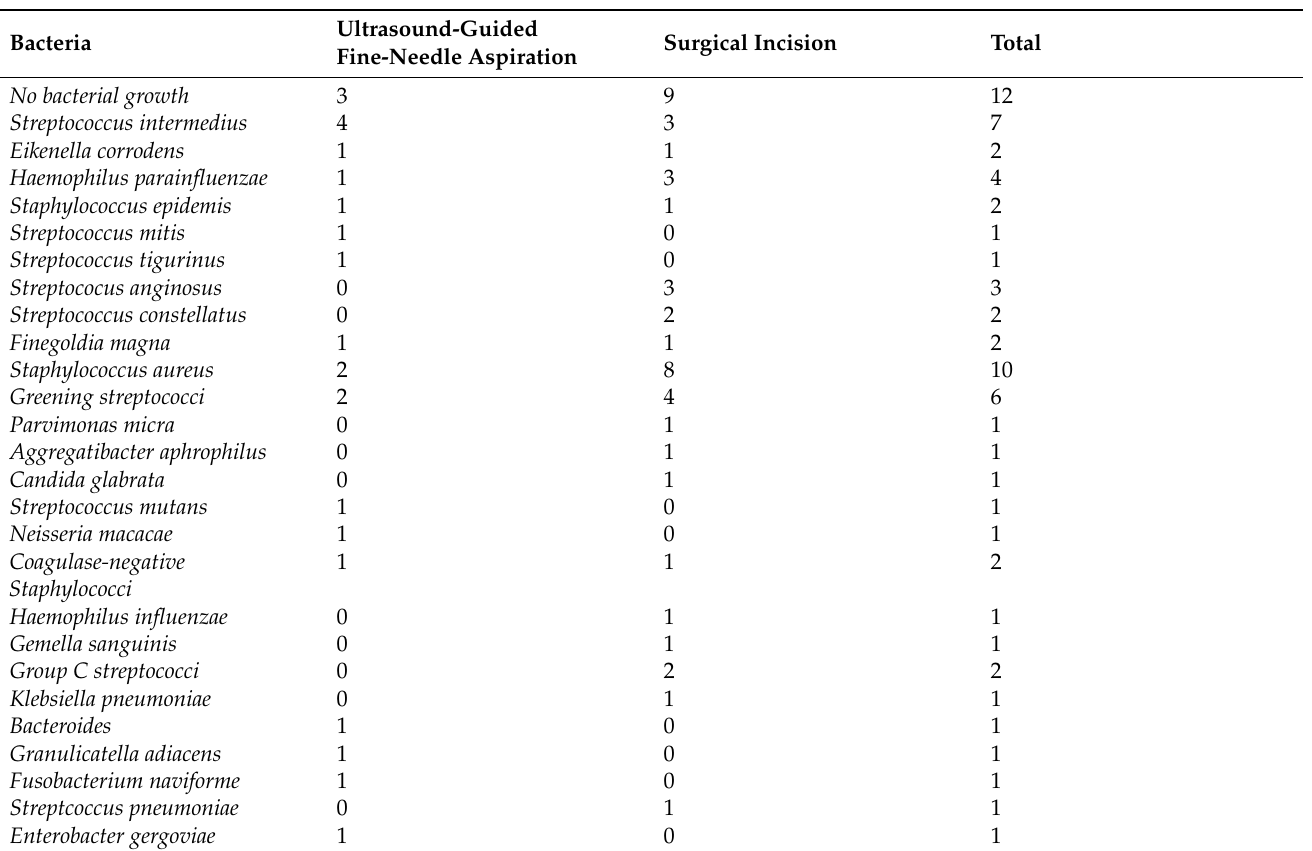
Table 4. Microbiological results (where available) in patients undergoing ultrasound-guided needle aspiration and surgical